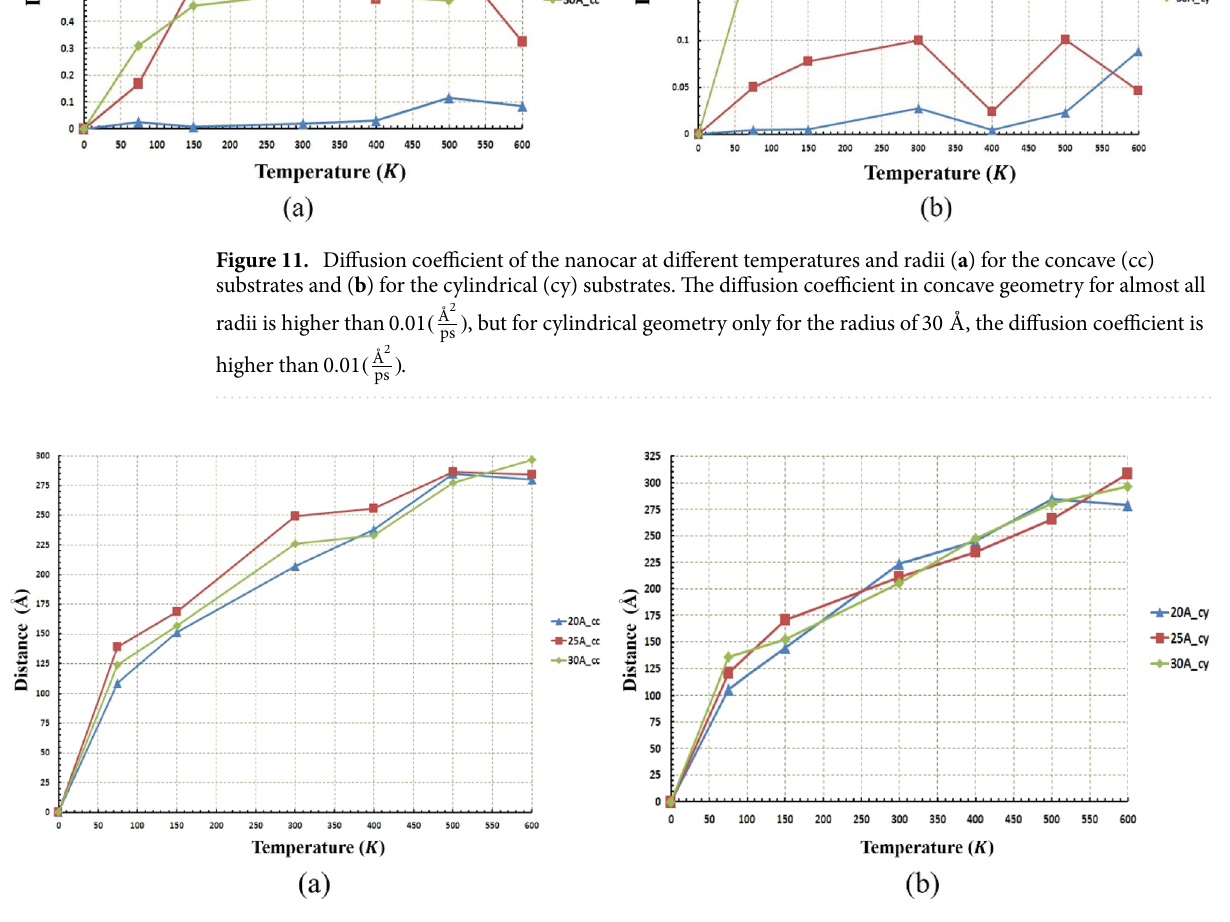
Figure 12. Distance traveled by the nanocar at different temperatures and radii ( a ) for the concave (cc) substrates and ( b ) for the cylindrical (cy) substrates. The shape of the geometry and the radius do not